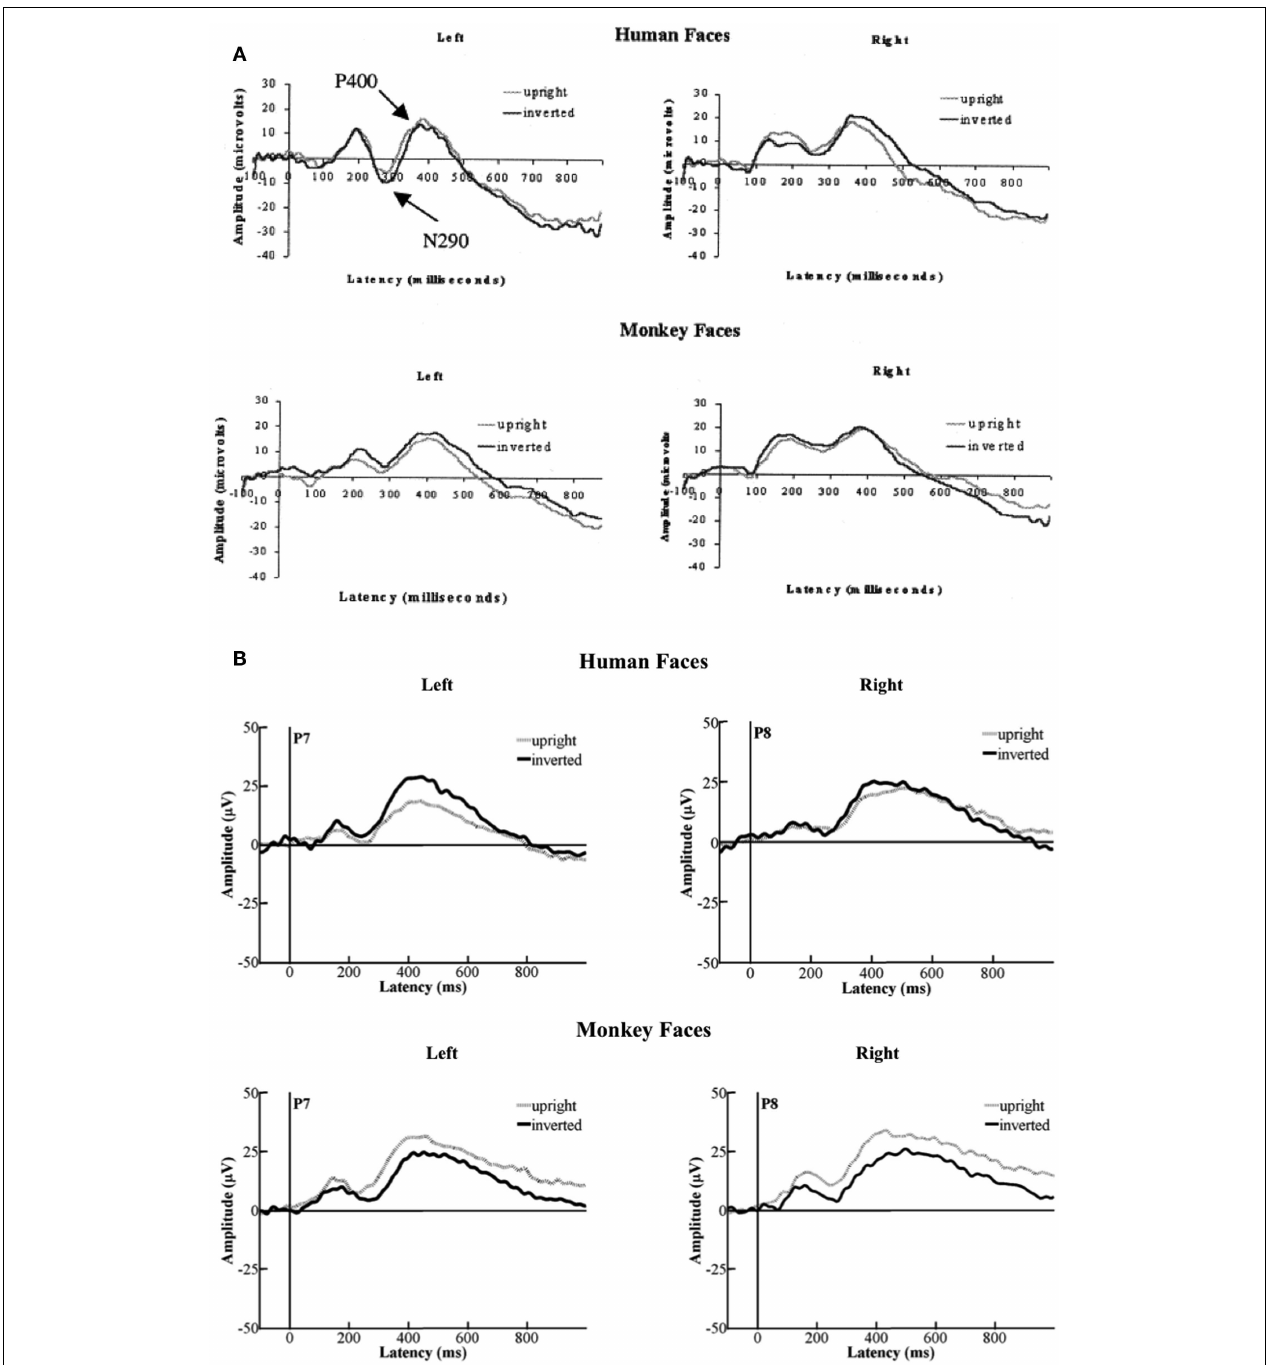
As can be seen, the morphologies of the original ERPs and ours are very similar. However, the directionalities in terms of which condition elicited the more negative or positive responses are